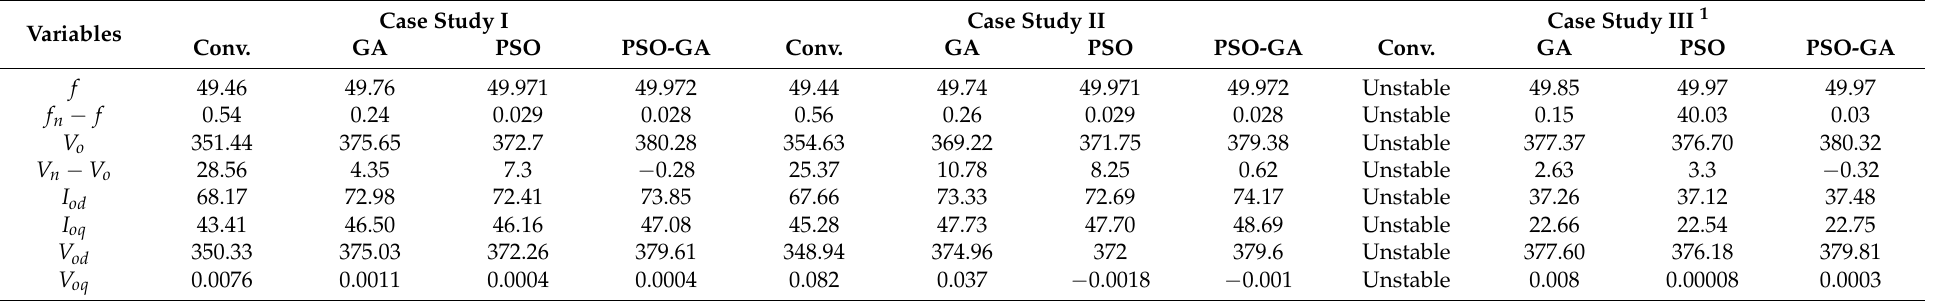
Table 6. The comparative analysis of designed controllers’ steady-state values in different case